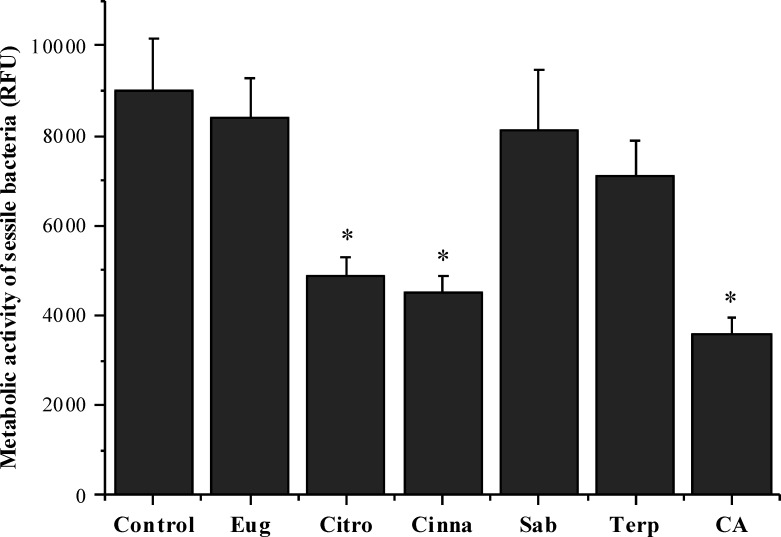
Antibacterial activity of different phytochemicals on S.mutans biofilm.*P < 0.05, significant reduction compared to control DMSO (5%, v/v) . Eugenol (Eug), citronellol (Citro), trans-cinnamaldehyde (Cinna), sabinene hydrate (Sab), terpineol (Terp), and cinnamic acid (CA).